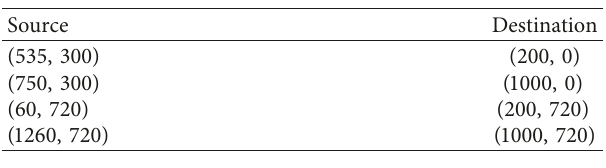
Figure 9: Result of the image of the lane. Table 1: Perspective coordinates.